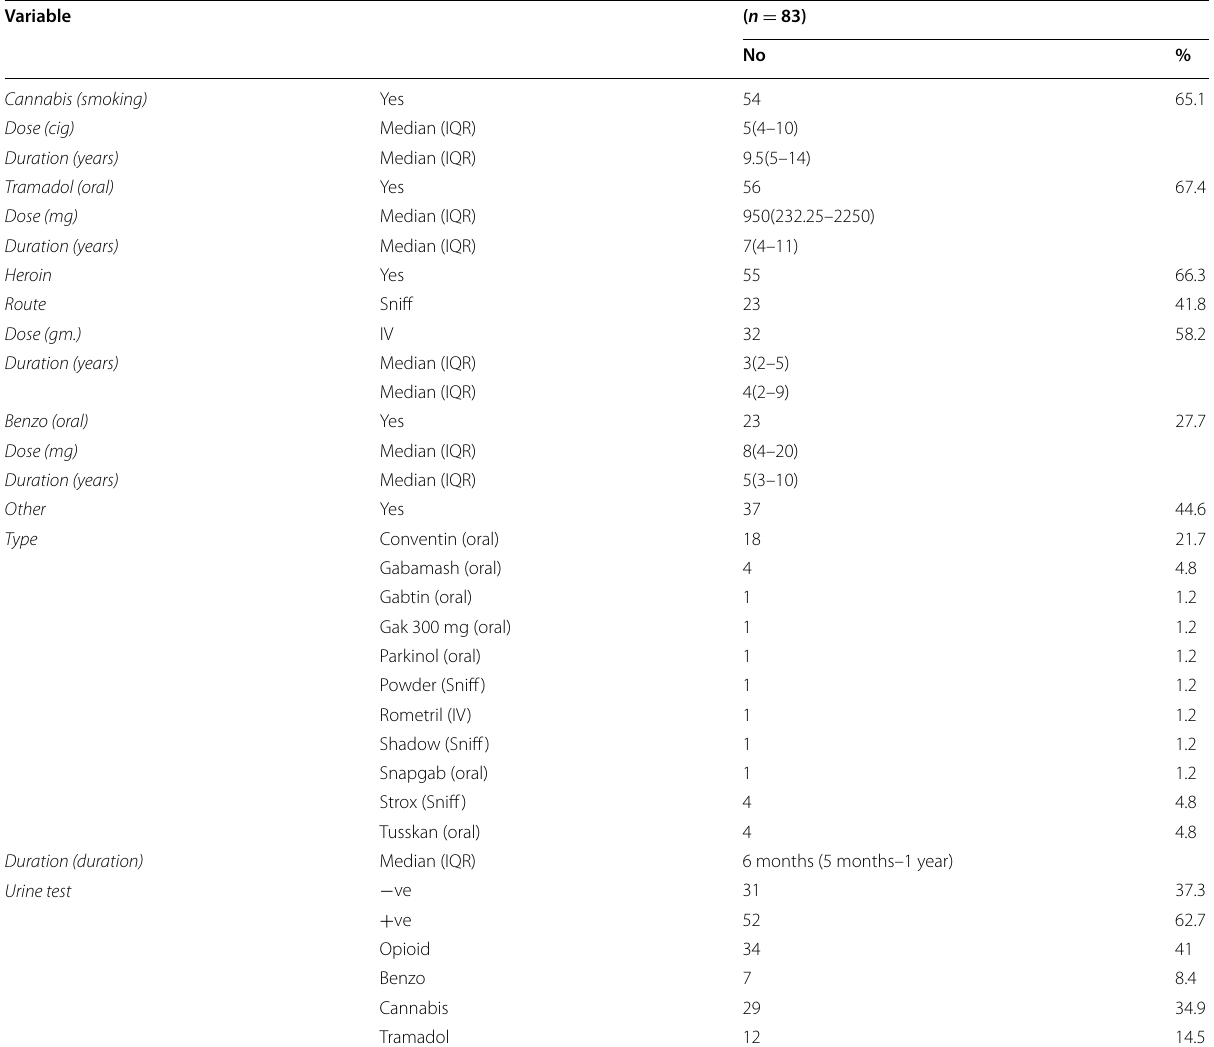
Table 3 Characteristics of other substances of abuse among the studied group